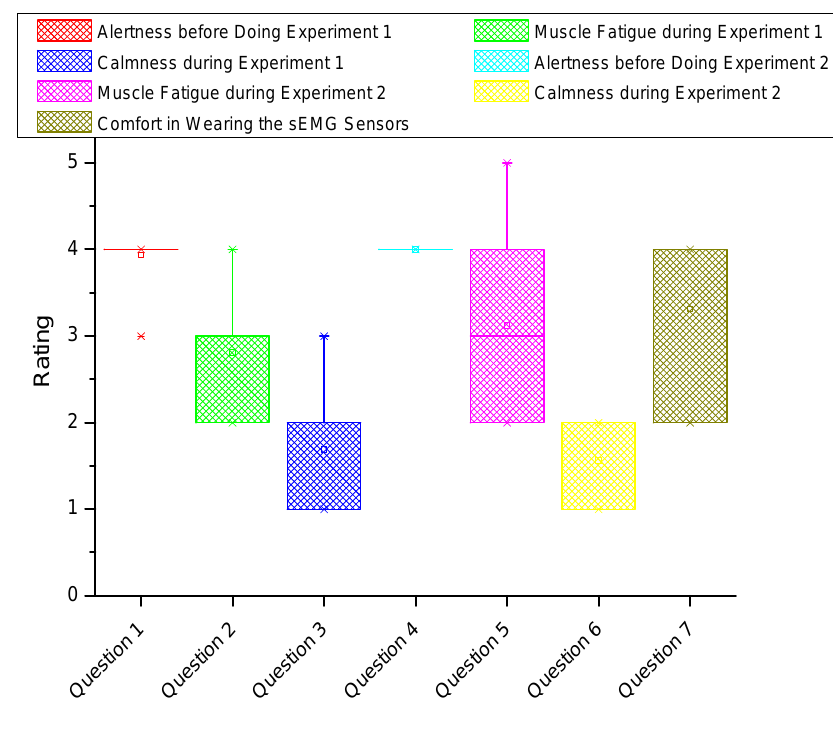
Figure 10. Statistics of the survey results regarding the fatigue experiments. Totally, 7 questions are proposed on the alertness, muscle fatigue feeling, calmness and comfort in the fatigue